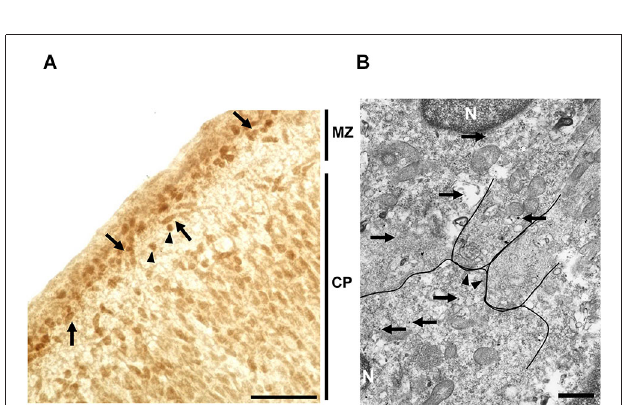
FIGURE 6 | Localization of taurine in the neonatal MZ . (A) Taurine immunoreactivity was observed both in the MZ and cortical plate (CP) in coronal sections from the P0 rat forebrain. Note that both Cajal-Retzius-like cells (arrows) and non-Cajal-Retzius-like cells (arrowheads) showed taurine immunoreactivity. Scale bar: 40 µ m. (B) Electron microscopic analysis using section immunolabeled for taurine (silver-intensified ultra-small gold particles (arrows)), indicating that taurine was intracellularly localized in cells located in the MZ. Arrows indicate taurine-immunoreactive signals. The postsynaptic density (arrowheads), nucleus (N). Note that taurine signals were not detected in presynaptic structures. Scale bar: 500 nm.